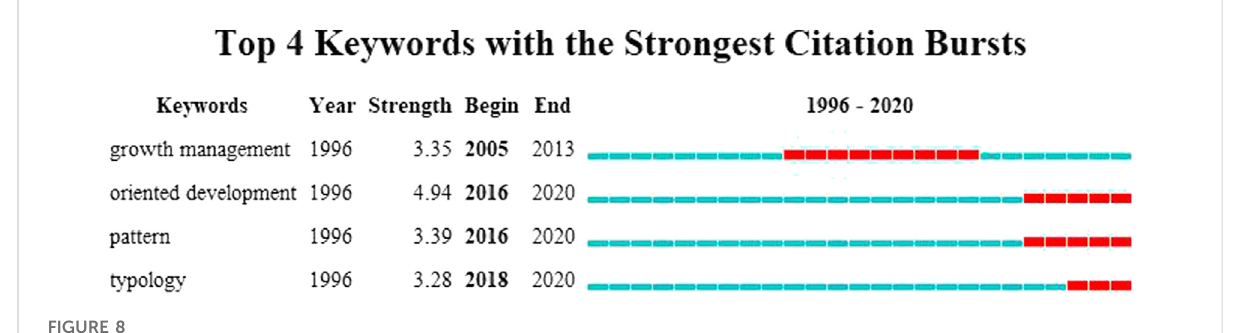
FIGURE 8 Top four keywords with the strongest citation bursts on TOD